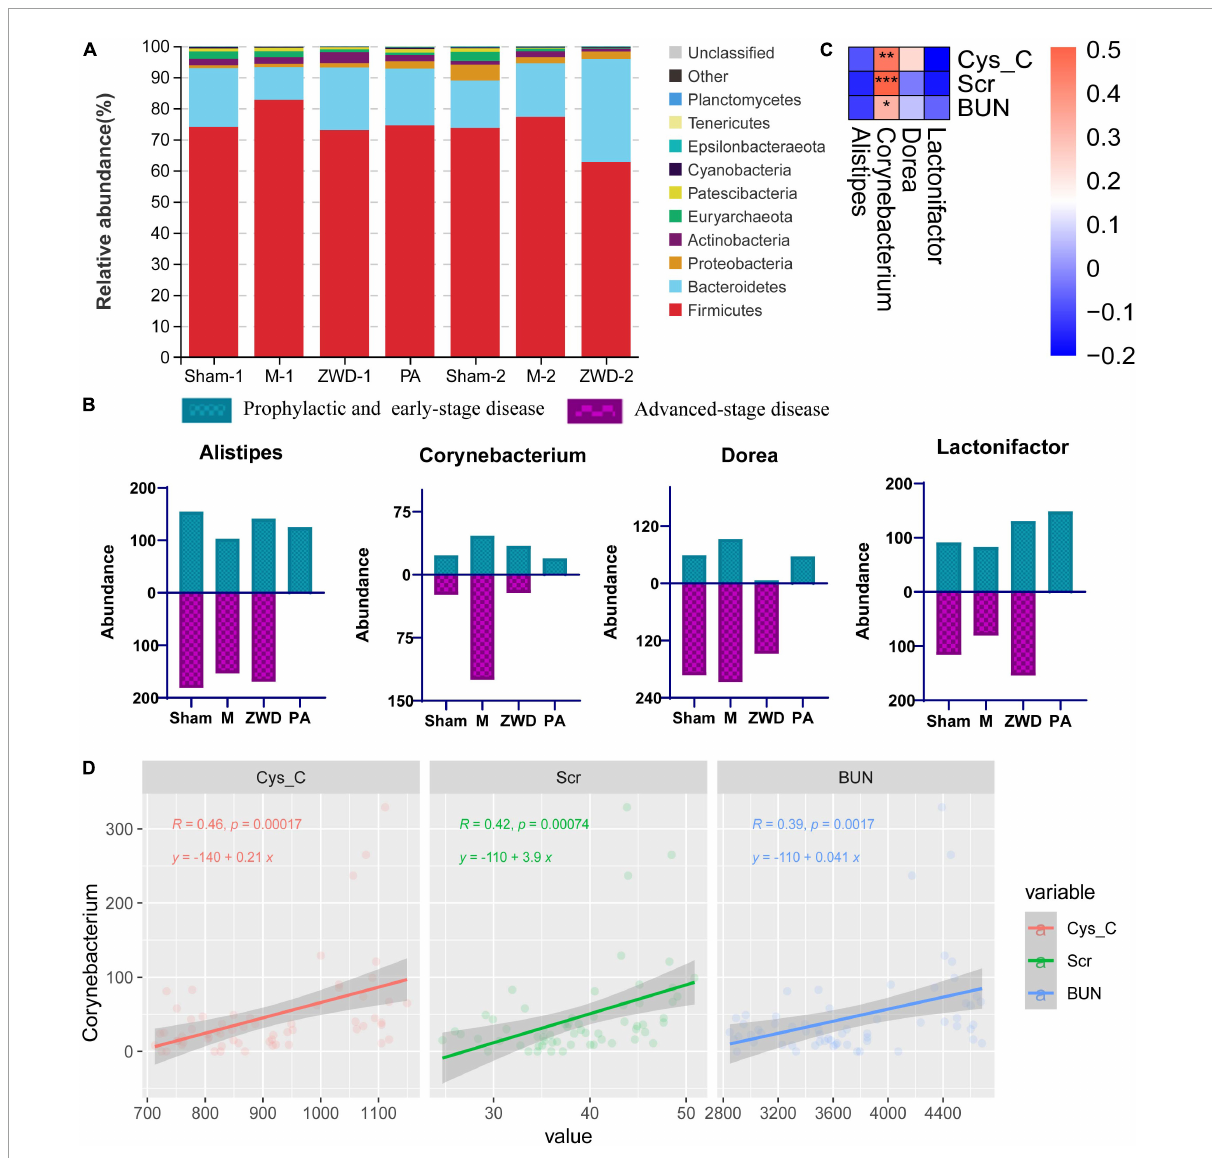
FIGURE4 (A) Stacked column graph representing the relative abundance of gut bacterial taxa at the phylum level in the different groups. (B) Gut microbiota differences at the genus level among each groups. (C) Spearman correlation analysis of three renal function indicators (Cys-C, Scr, and BUN) and four differential genera. Color intensity represents the magnitude of correlation; * P < 0.05, ** P < 0.01, *** P < 0.001. (D) Regression analysis between Corynebacterium and three renal function